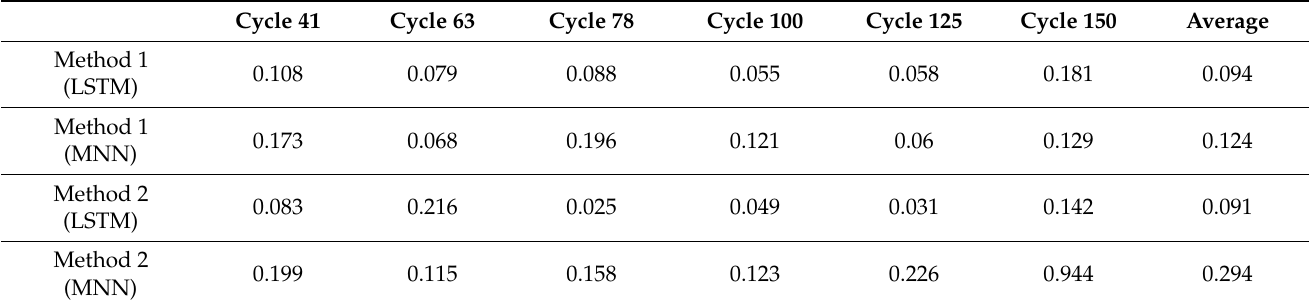
Table 2. SOC estimation error for each model using the NASA battery dataset.